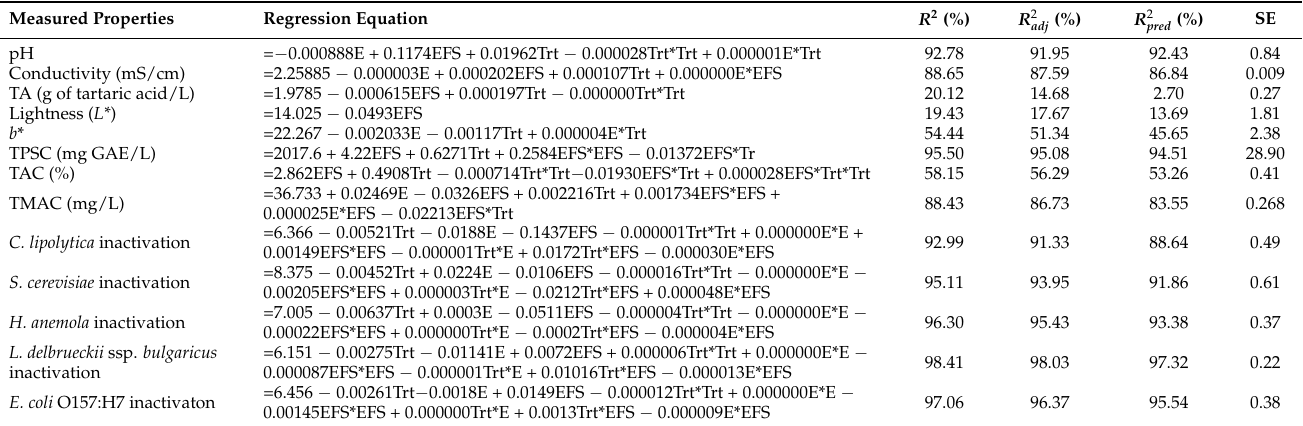
Table 5. Regression analyses of the physicochemical properties and microbial inactivation of red wine samples treated by pulsed electric